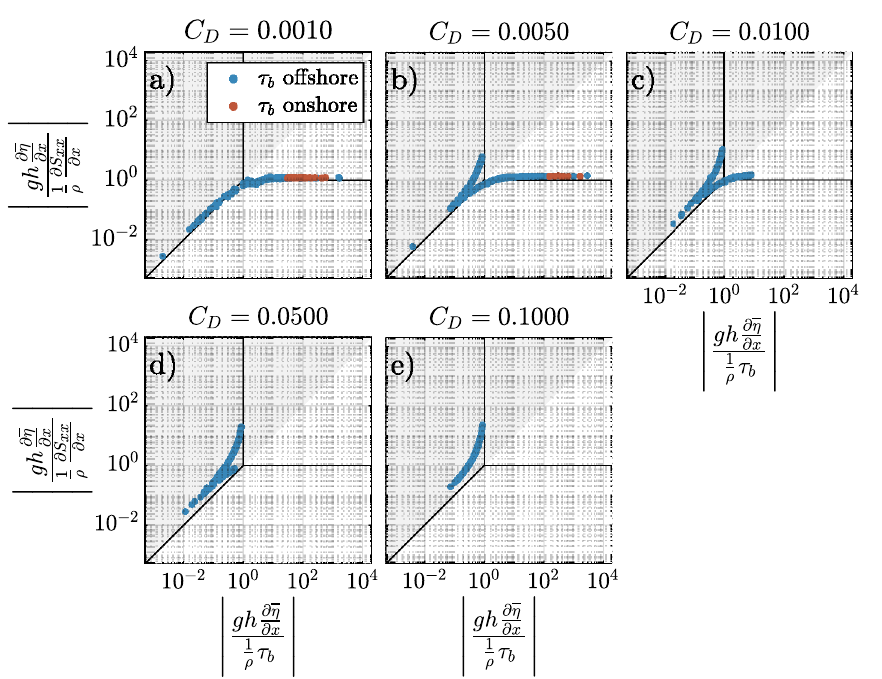
Figure 9. Momentum phase diagrams of simulations with varying reef flat drag coefficients. Momentum terms are evaluated over a tidal period at the location indicated in Fig. 2a. Markers are colored according to the direction of the bottom shear stress τ b